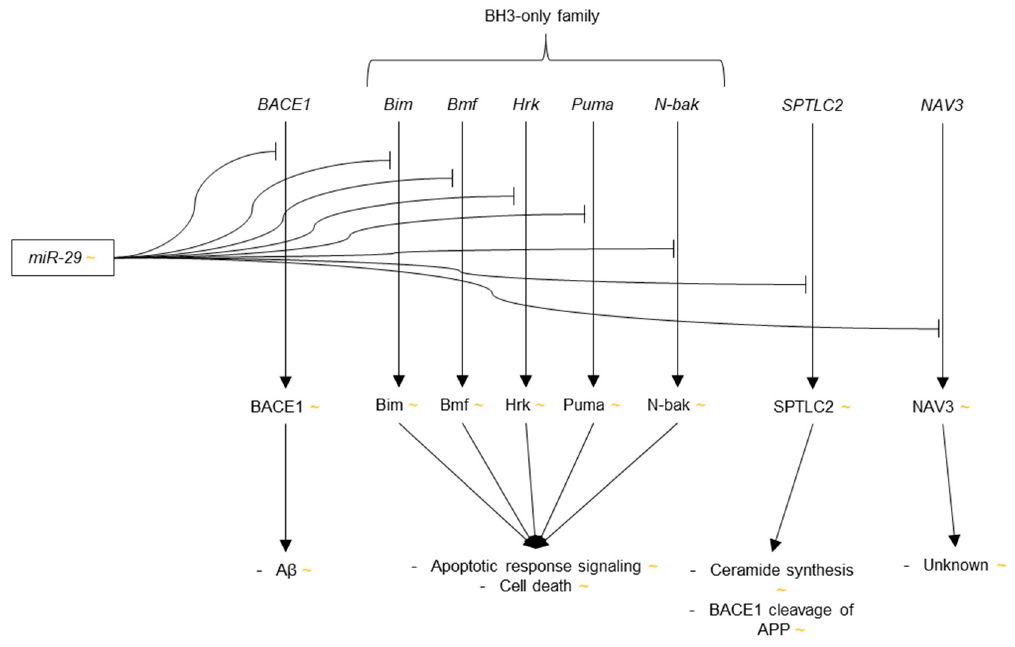
Figure 4. Regulation by miR-29. miR-29 inhibits the translation of BACE1, several Bcl-2 Homology 3 (BH3)-only family proteins (Bim, Bmf, Hrk, Puma, and N-bak), SPTLC2 and neuron navigator 3 (NAV3). The debatable levels of miR-29 expression in AD brain are indicated by the yellow tilde symbol (~), as are the hypothetical expression levels of the proteins regulated by miR-29 and their cellular effects.